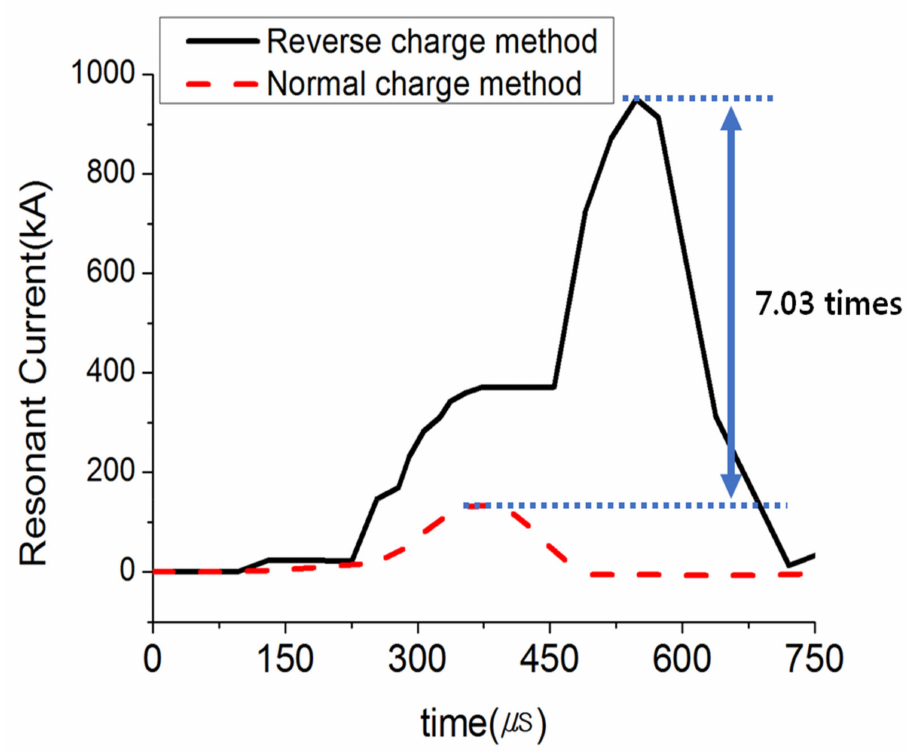
Figure 5. Comparison of the magnitude of resonant current between the reverse-charge method and the normal-charge method in the DCCB in the proposed